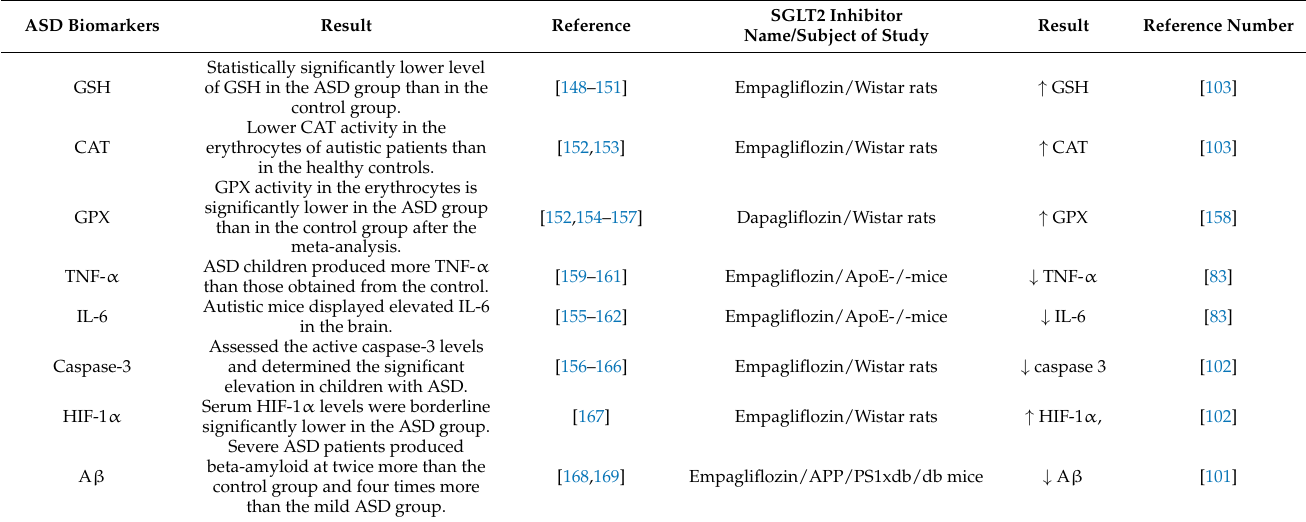
Table 3. Comparison of the oxidative stress biomarkers’ blood levels in autistic patients with a mutual therapeutic biomarker impact of the SGLT2 inhibitors. ↑ —increase, ↓